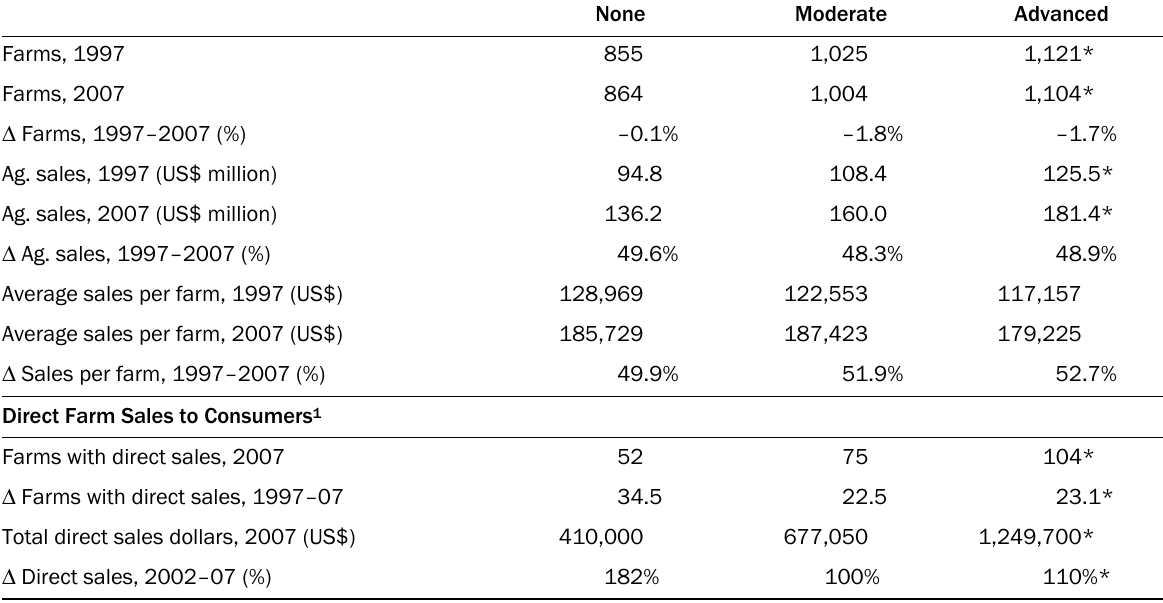
Table 6. Current Status and Rates of Change in Local Farm Sector by Level of